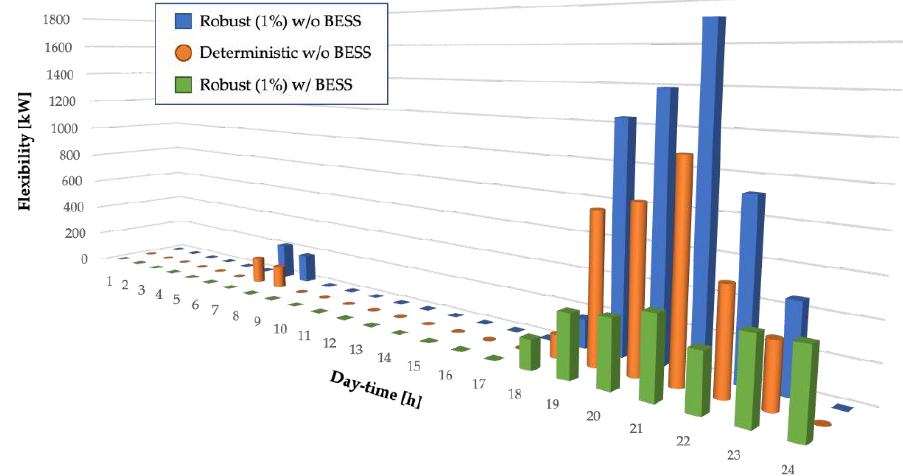
Figure 13. Request of demand curtailment with BESS (green bars) vs. solutions without BESS. The objective function varies from 298 k € to 253 k € for the robust solutions without BESS (deterministic cost equal to 196 k € ) and from 154 k € to 144 k € for the robust